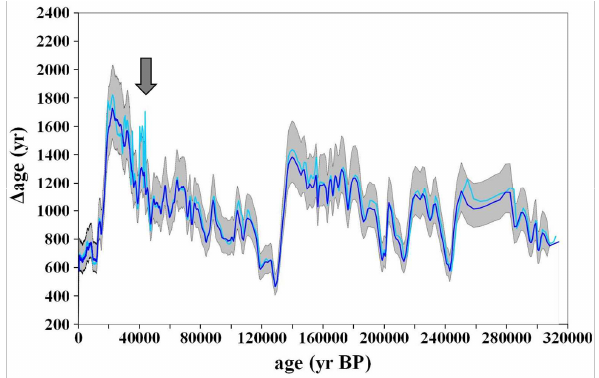
Fig. 5 : ∆ age evolution on the TALDICE-1 age scale, calculated by the inverse model (light 1091 Fig. 5. 1 age evolution on the TALDICE-1 age scale, calculated blue line) and by the firn densification model (dark blue line). The grey shade represents the 1092 by the inverse model (light blue line) and by the firn densification error interval based on accumulation rate uncertainties of ± 20 %. The maximum difference 1093 recorded between ∆ age estimates from the inverse method and from the firn densification 1094 model (dark blue line). The grey shade represents the error inter- model is pointed by the arrow: it occurs around 40 kyr BP and reaches 400 yr. The difference 1095 val based on accumulation rate uncertainties of ± 20%. The maxi- remains below ±200 yr for other times. 1096 1097 mum difference recorded between 1 age estimates from the inverse method and from the firn densification model is pointed by the ar- row: it occurs around 40kyr BP and reaches 400yr. The difference remains below ± 200 yr for other